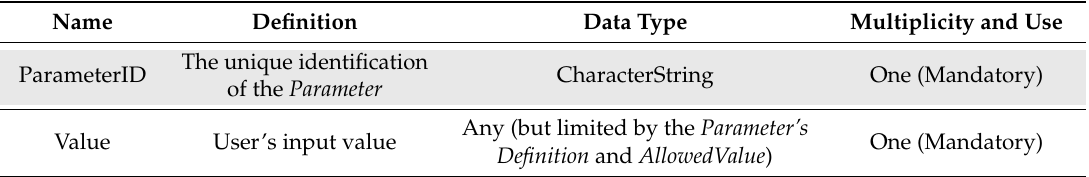
Table 11. Properties of the Input